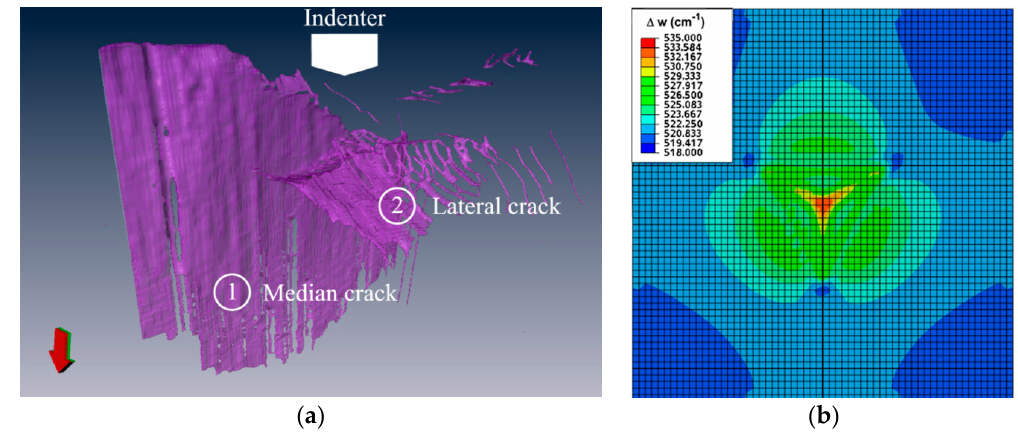
Figure 7. ( a ) 3D reconstruction of subsurface cracks corresponding to a 120 mN Berkovich indent, showing: one of the three median cracks (1); and a lateral crack (2). ( b ) Simulation of the shift of the UV Raman TO phonon line for a 150 mN indent without cohesive elements.